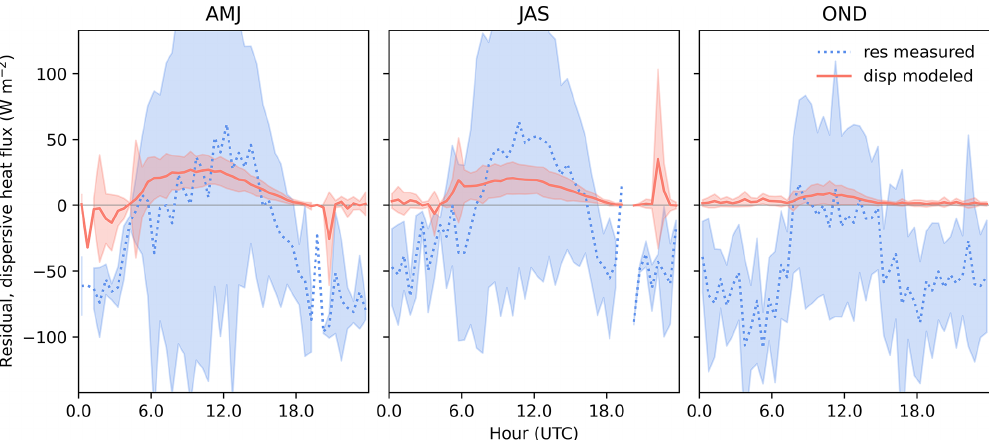
Figure 7. Mean diurnal cycles of the measured residual (blue) and the modelled dispersive fluxes (red) for different seasons (AMJ: April, May, June; JAS: July, August, September; OND: October, November, December) for the DK-Sor dataset. The semi-transparent blue and red areas represent the respective standard